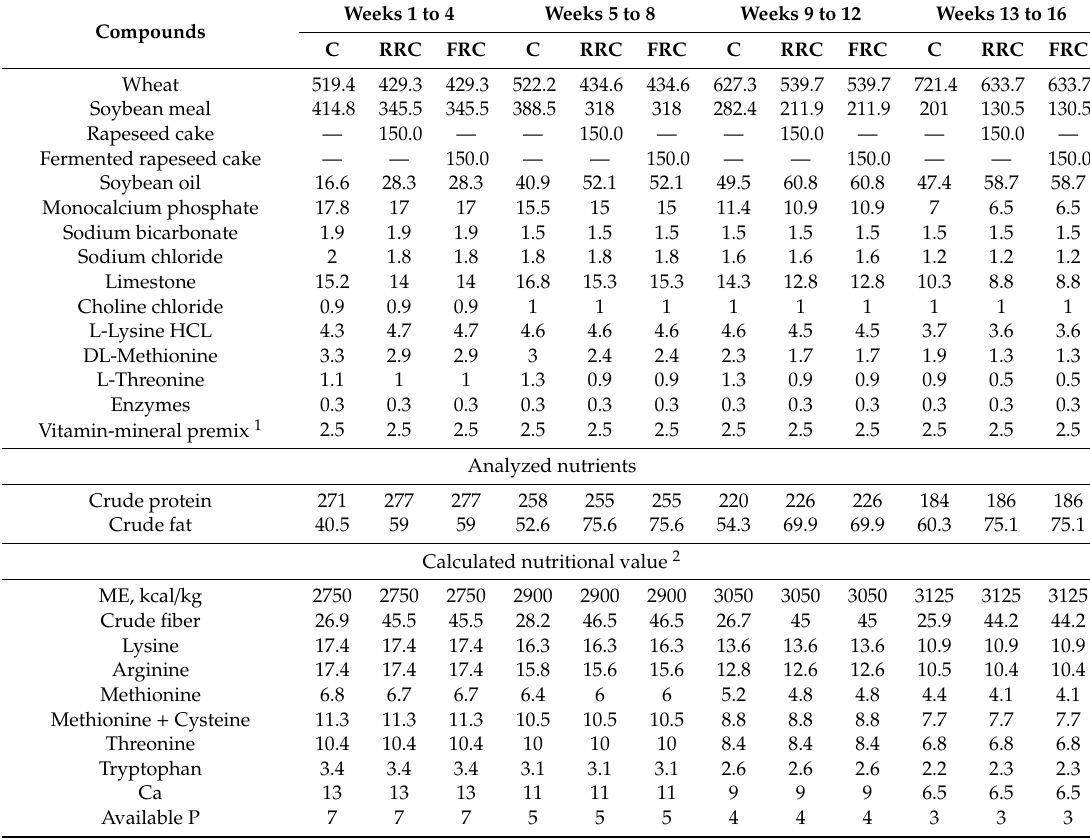
Table 1. Composition and calculated analysis of control (C) and experimental diets containing raw rapeseed cake (RRC) or fermented rapeseed cake (FRC) fed during four feeding periods to turkeys aged 1–112 days, in g / kg as-fed basis (unless indicated